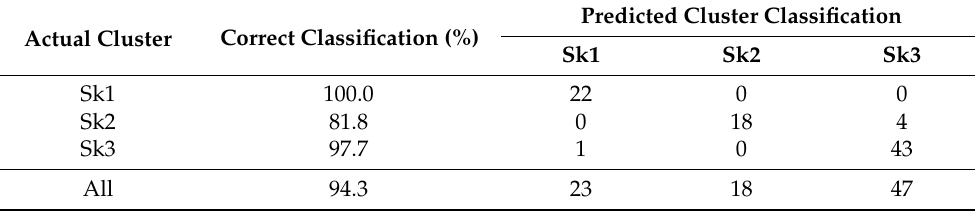
Table 5. Classification results of LDA presenting percentage predicted clusters membership for actual